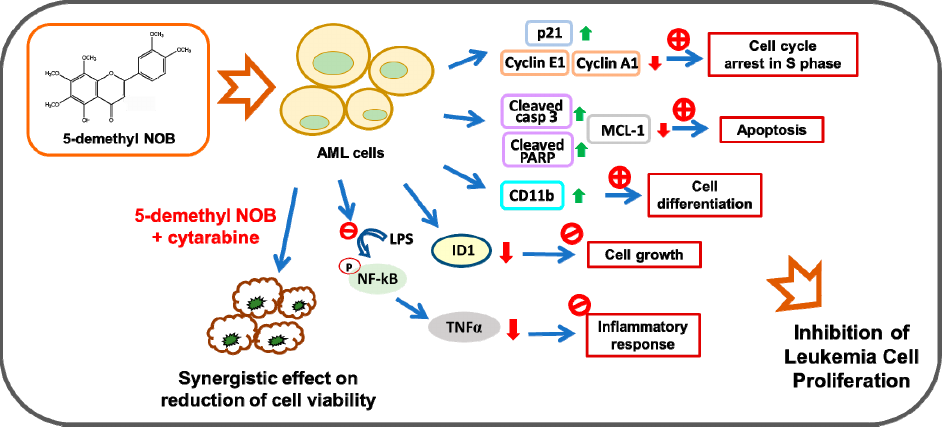
Figure 9. A hypothetical mechanism of the antileukemic effects of 5-demethyl NOB in human AML cells. 5-Demethyl NOB inhibits leukemia cell proliferation through the regulation of cell cycle arrest, apoptosis, cell differentiation, cell growth, and the NF- κ B/TNF- α -mediated inflammatory response. 5-Demethyl NOB regulates cell proliferation through a substantial reduction in ID1 expression in AML cells. Cytarabine combined with 5-demethyl NOB showed a synergistic effect on the reduction of cell viability in AML cells.